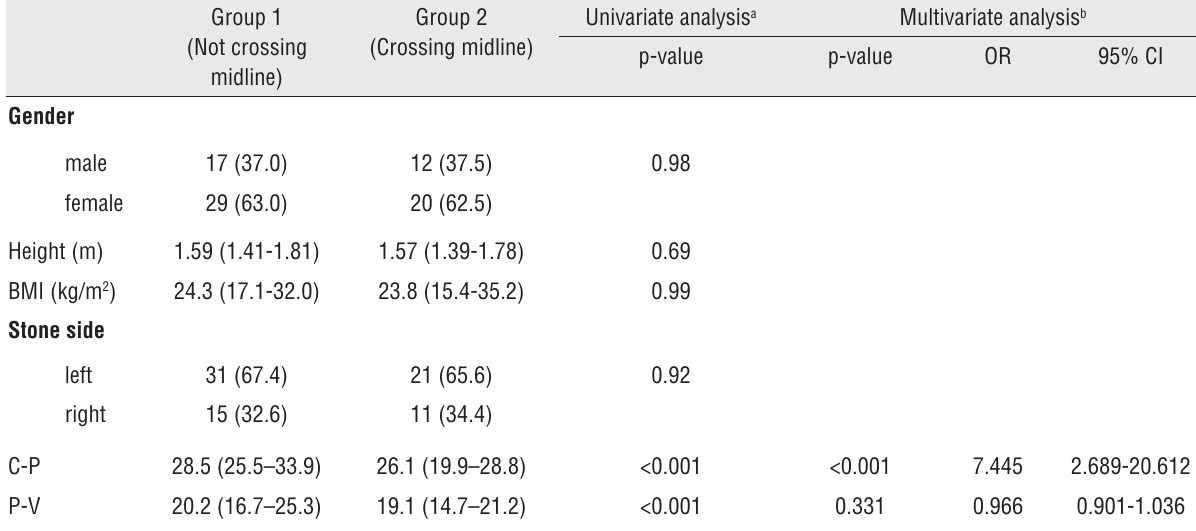
Table 2A - Multivariate analysis of patients with 24 cm ureteral stents.